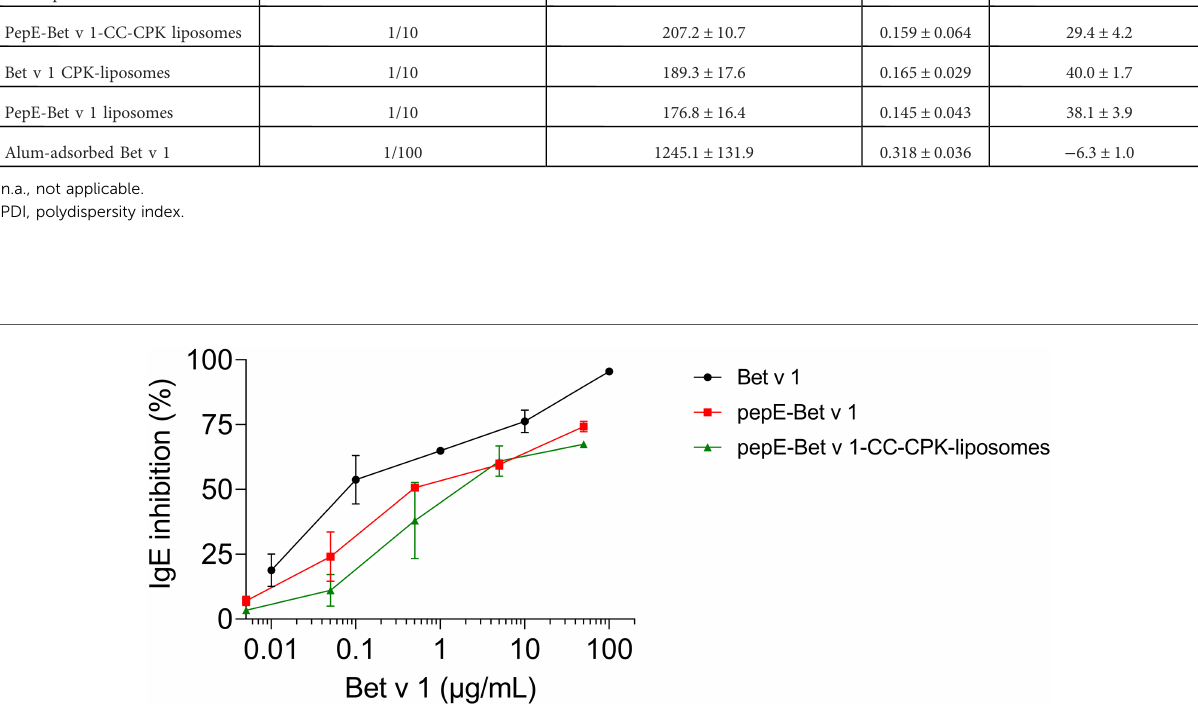
FIGURE 2 ImmunoCAP IgE inhibition assay. Serially diluted (10-fold) Bet v 1, pepE-Bet v 1 and pepE-Bet v 1-CC-CPK-liposomes were pre-incubated with pooled sera from birch pollen-allergic patients. After pre-incubation, the sample dilutions were loaded onto rBet v 1 ImmunoCAPs to determine the amount of uncomplexed IgE. An ImmunoCAP loaded with serum only was used as uninhibited IgE binding control. The shown graphs are normalized with regard to the uninhibited control and are an average of two independent experiments